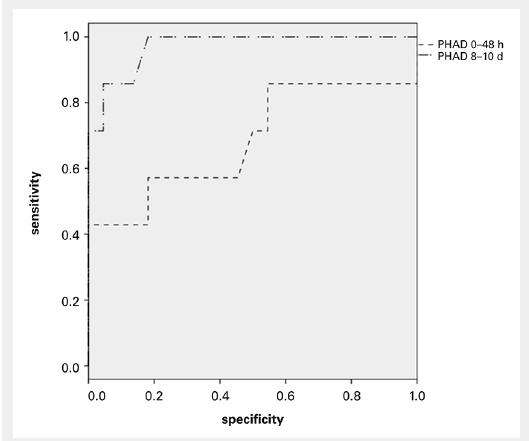
Receiver operator curve (ROC) -analysis of Parramatta Hospitals’ Assessment of Dysphagia (PHAD) for prediction of “prolonged impairment of deglutition”. At second assessment (mean 8.7 days, SD ± 1.4 post stroke), ROC analysis for PHAD score in relation to serious to severe impairment of oral intake defined as a Bogenhausen-dysphagia-score, part 2 (BODS-2) score of ≥4 at 5–7 weeks after the stroke. Area under the curve (AUC) 0.971, 95% confidence interval 0.915–1.0. ROC analysis for PHAD score assessed in the first week: AUC 0.685, 95% CI